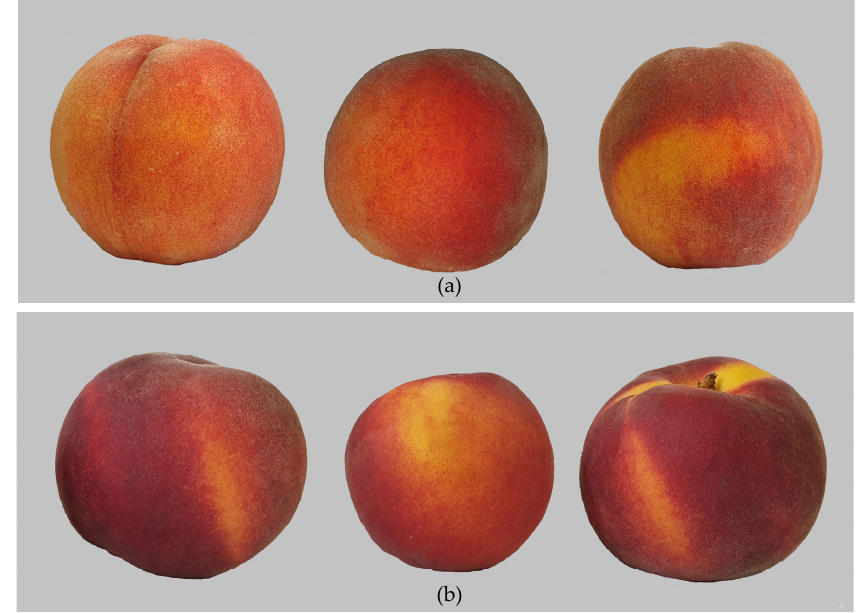
Figure 1. The images of whole ‘Redhaven’ peaches ( a ) and ‘Royal Glory’ peaches ( b ).